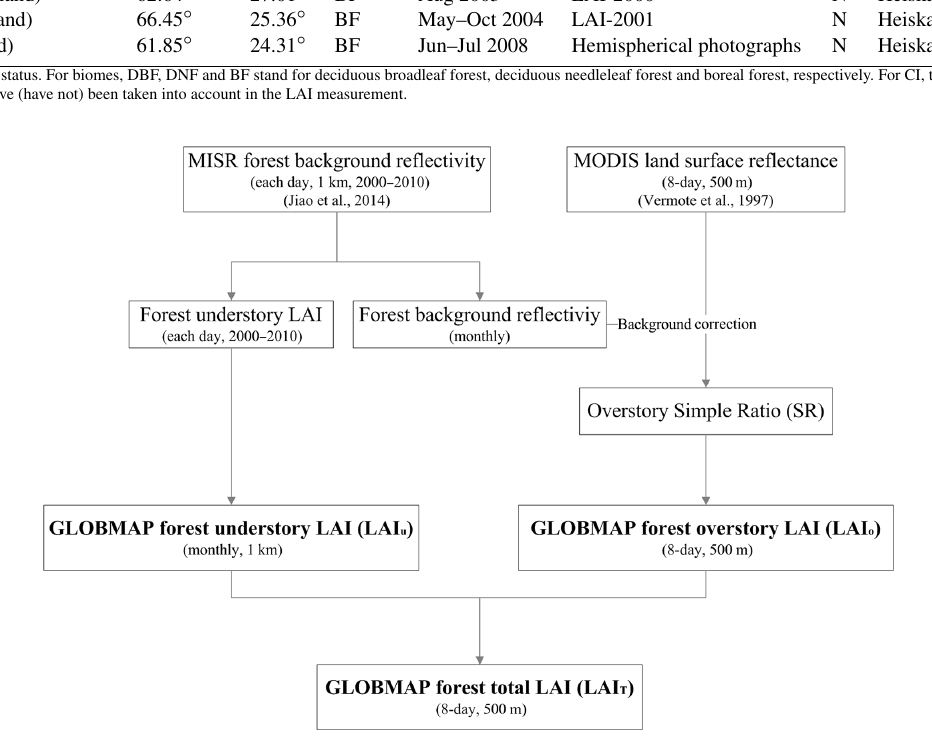
Figure 1. General flowchart for the GLOBMAP forest overstory and understory LAI separation